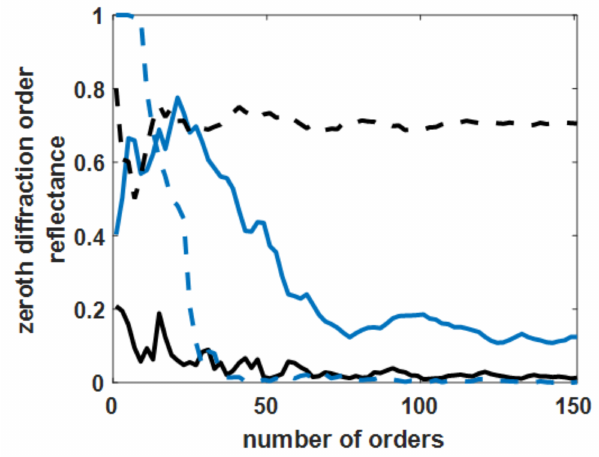
Figure 7. Optical reflectance of the p-polarization for four levels of rough surfaces with the varying number of diffracted orders included in the RCWA calculations. Note that the solid blue curve is for cl of 1 nm and h of 1 nm, the dashed blue curve is for cl of 1 nm and h of 20 nm, the solid black curve is for cl of 50 nm and h of 1 nm, and the dashed blue curve is for cl of 50 nm and h of 20